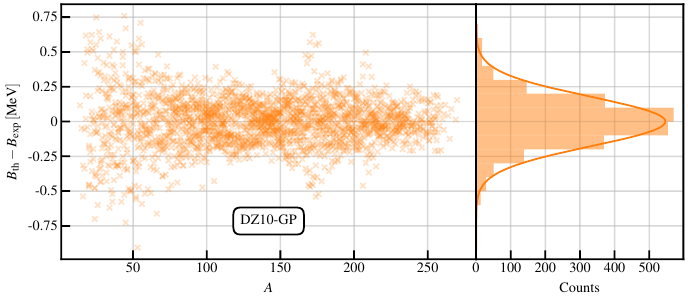
Figure 6. The same as Figure 3 but for the DZ10-GP model. See text for